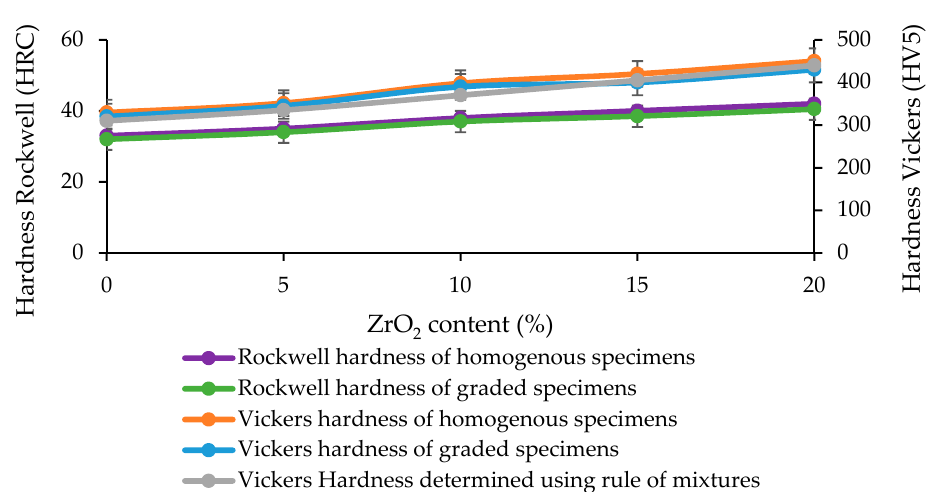
Figure 11. Vickers and Rockwell hardnesses of homogeneous specimens with different ZrO 2 contents and those of graded specimens.